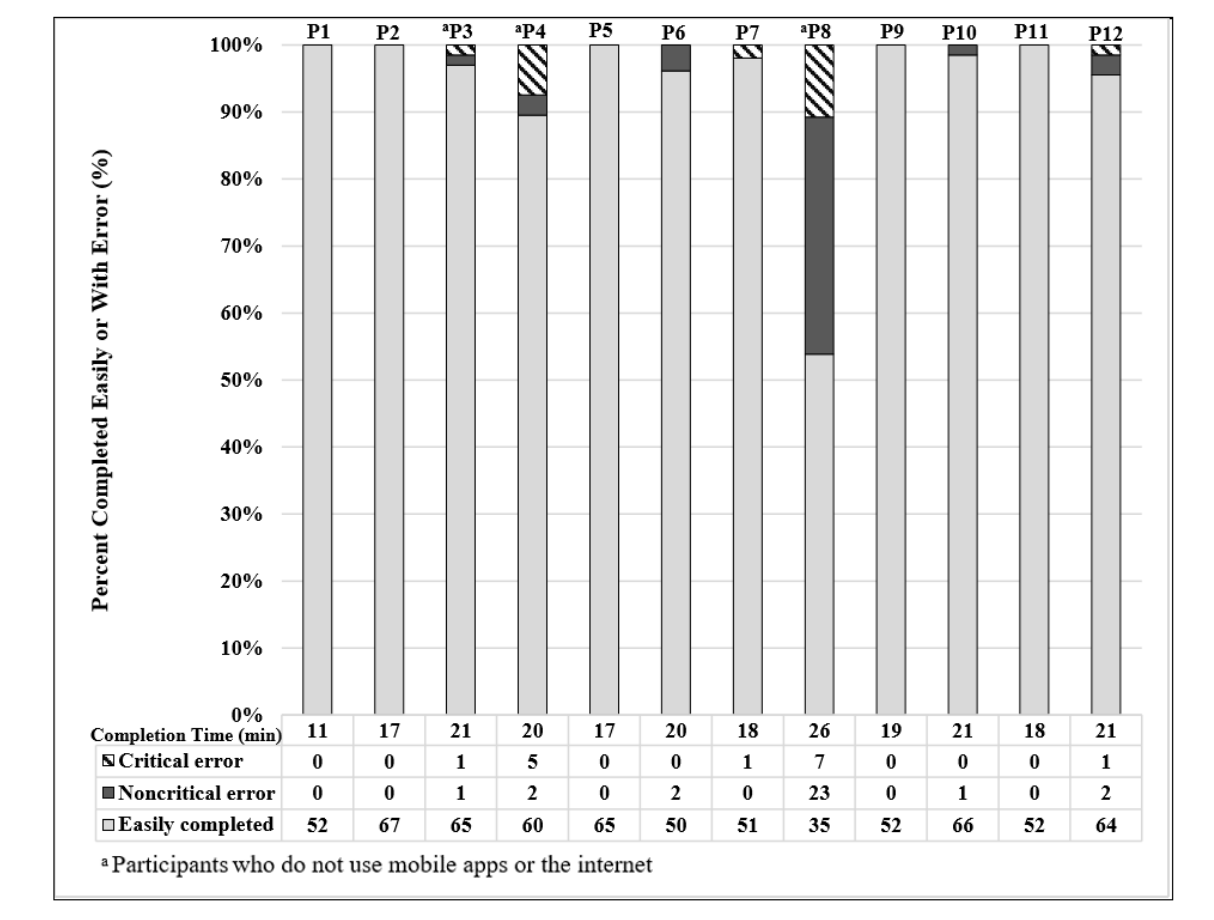
Figure 2. Usability testing results by